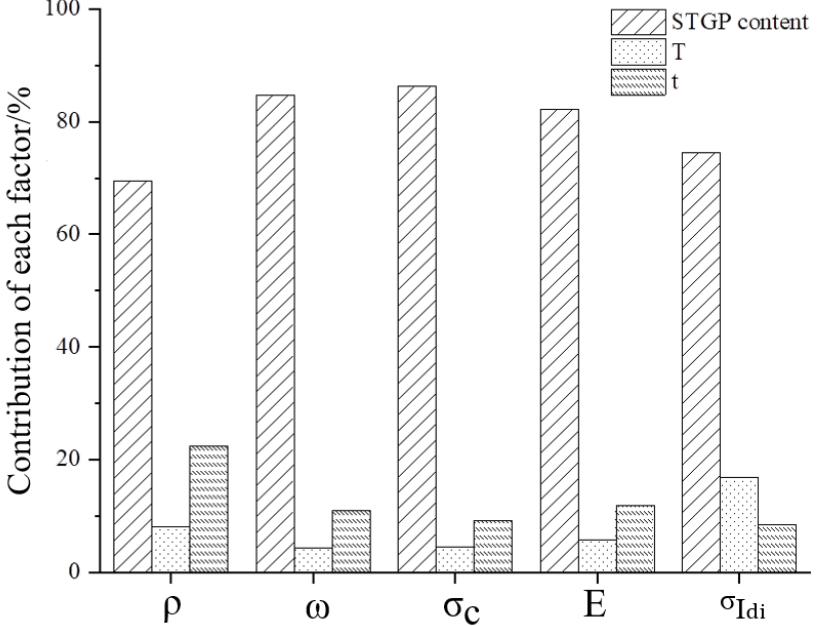
Figure 8. Contribution of each factor to the physical and mechanical properties of similar materials.